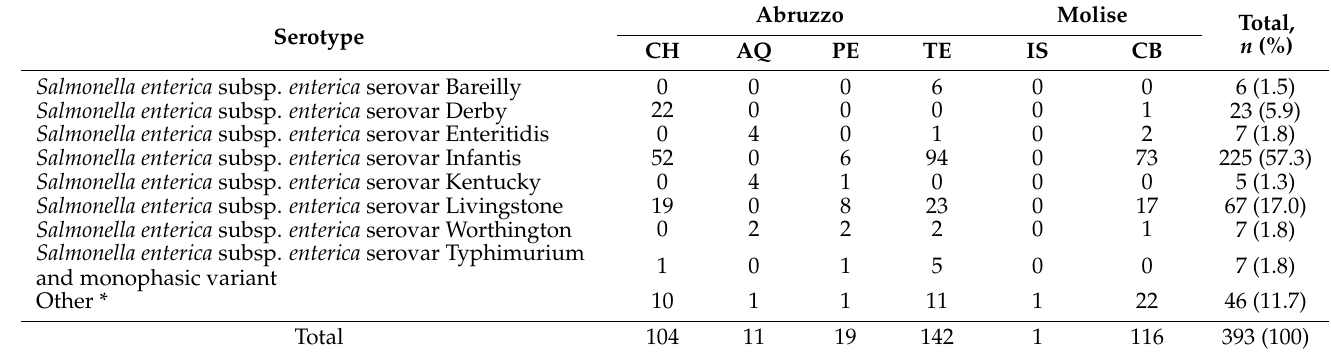
Table 6. Salmonella spp. serotypes isolated in individual provinces of Abruzzo and Molise Regions between 2015 and 2020. Values are numbers of